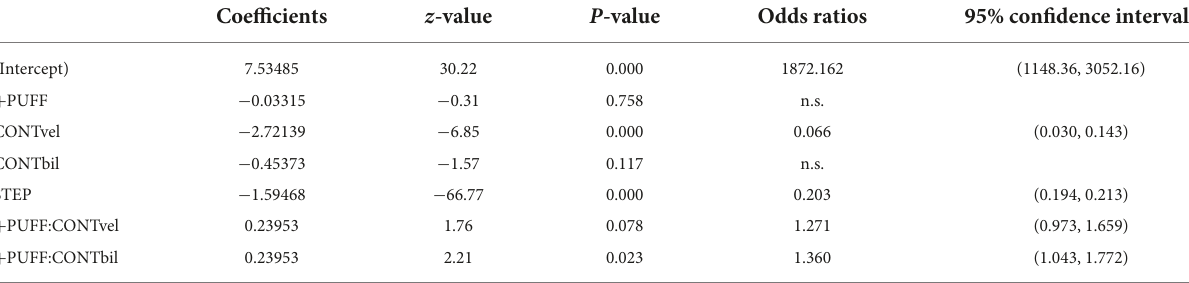
TABLE 4 Output of GLMM combining continua to show relative effect sizes (using odds ratios). Coefficients z -value